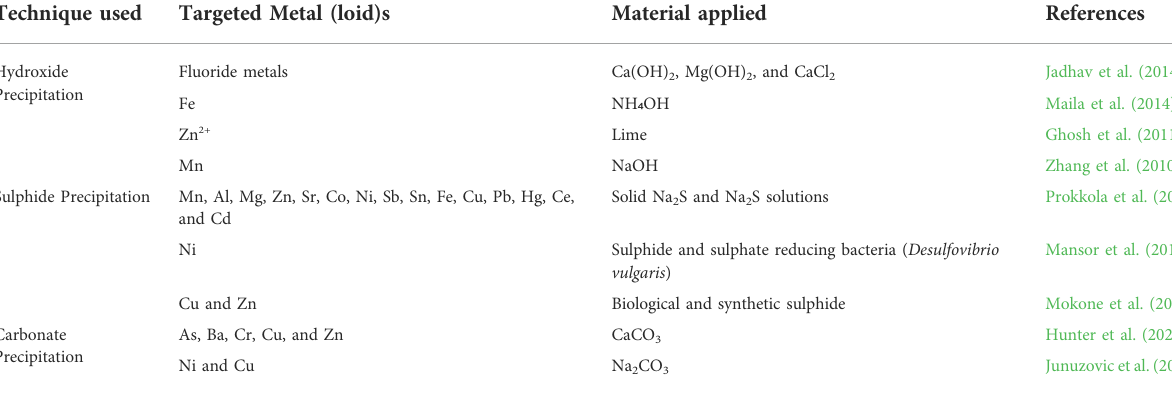
TABLE 4 Application of different materials used in the chemical precipitation technique for metal(loid)s